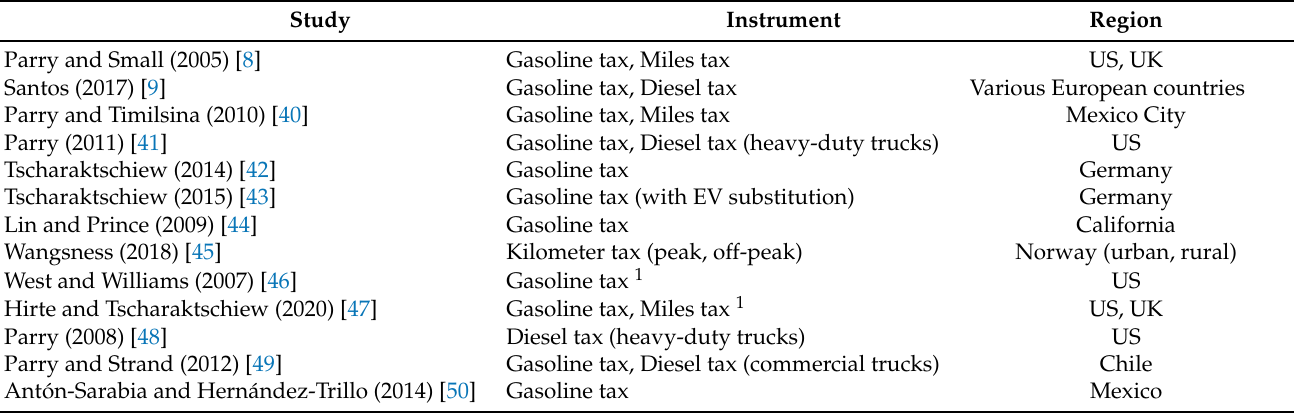
Table 1. Related Literature.